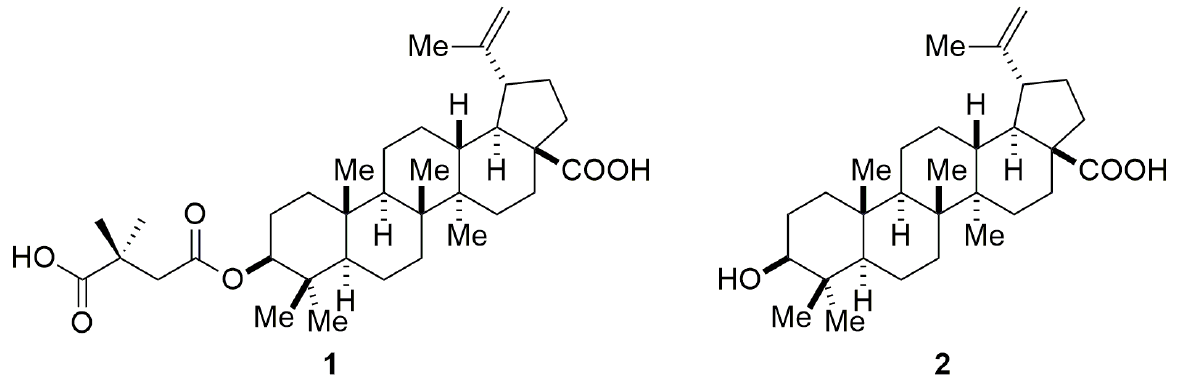
Figure 1 - Betulinic acid and its derivative Bevirimat ® ( 2 and 1 ,